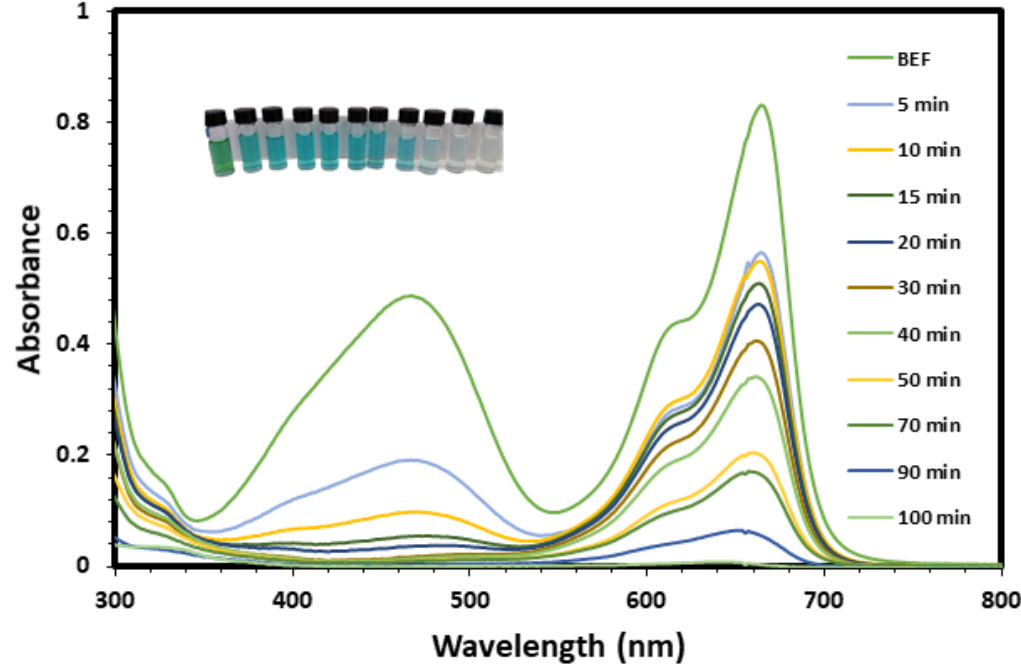
Figure 7. UV-Vis spectra of MO and MB dyes as a function of time in the presence of BMW ZnO NPs.